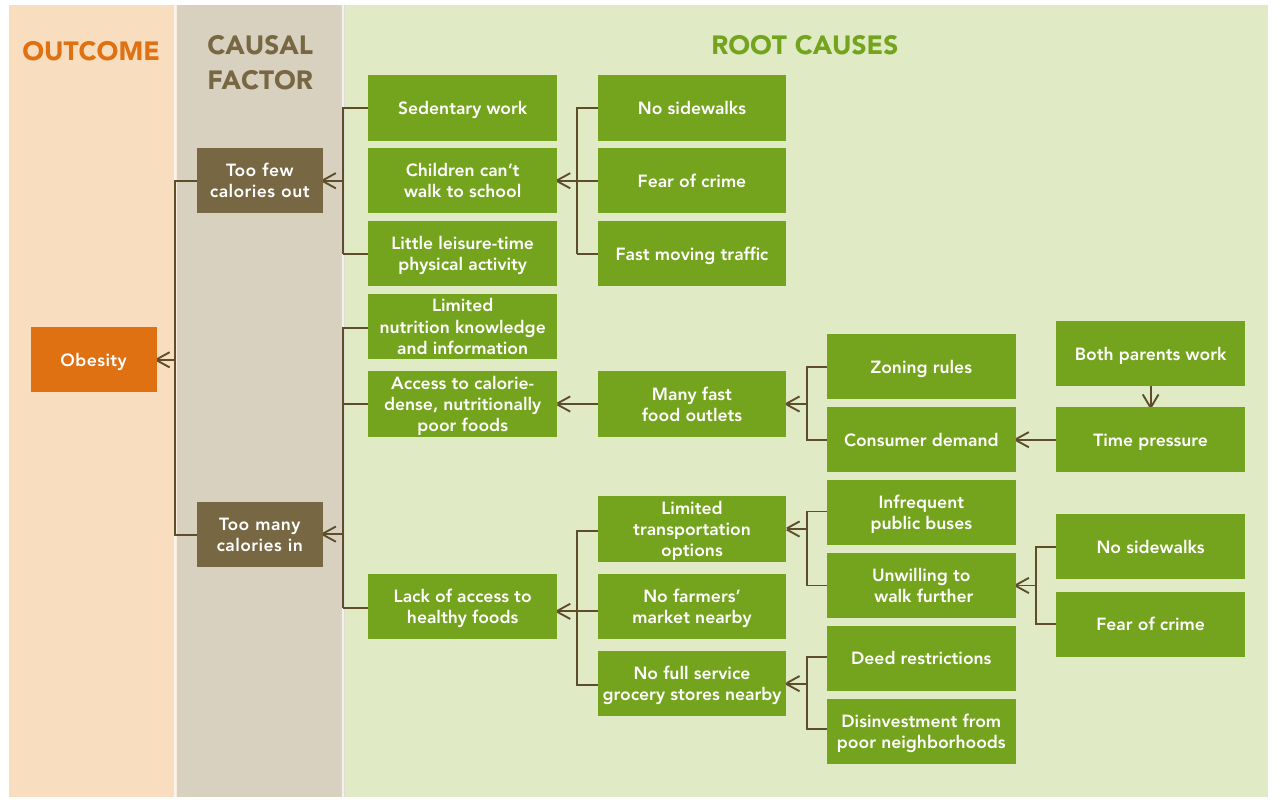
FIGURE 8. ROOT CAUSE